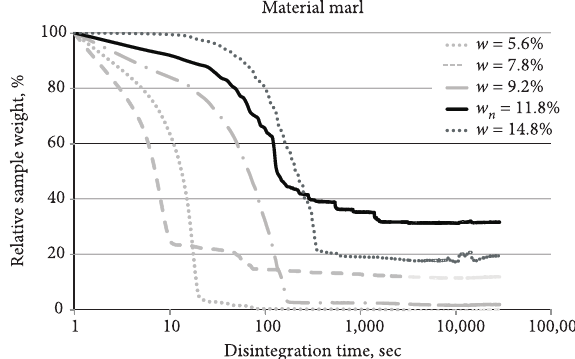
Fig. 7. Disintegration curves (Endell) of